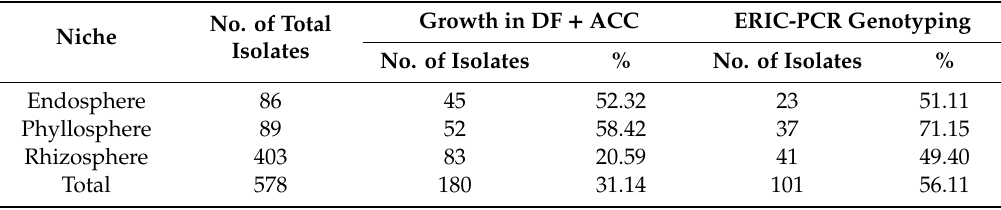
Table 1. Selection of putative ACC-degrading bacteria isolated from different niches of Antarctic vascular plants. Niche